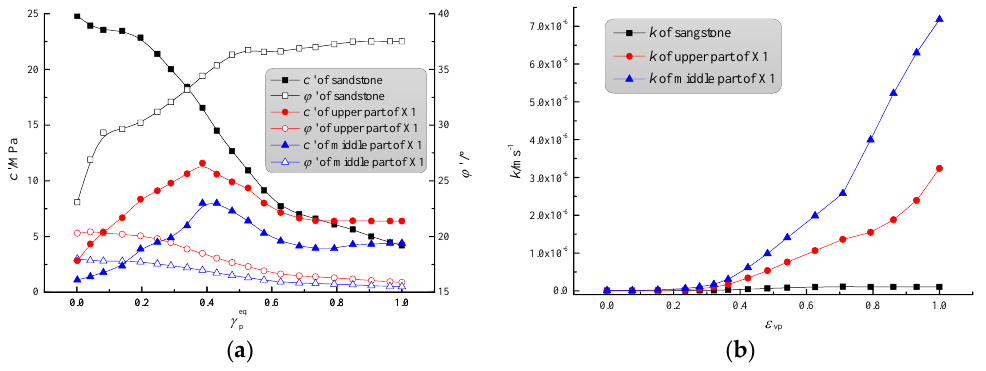
Figure 11. The evolution curve of c ’, ϕ ’ and k. ( a ) The relationship between c ’, ϕ ’ and ˆ γ eq p ;